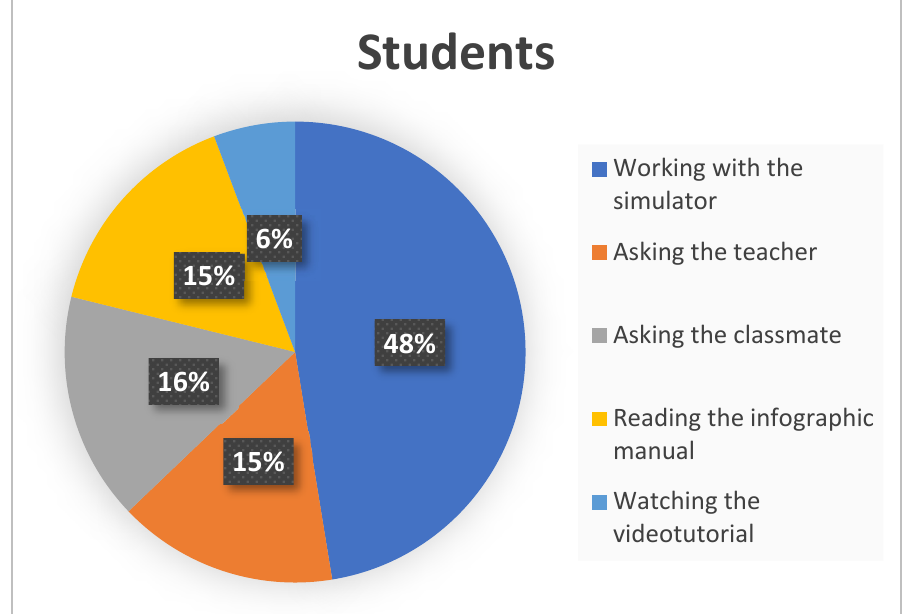
Figure 6. Percentages of the most effective strategies for knowledge/learning of the simulator in the student’s sample.